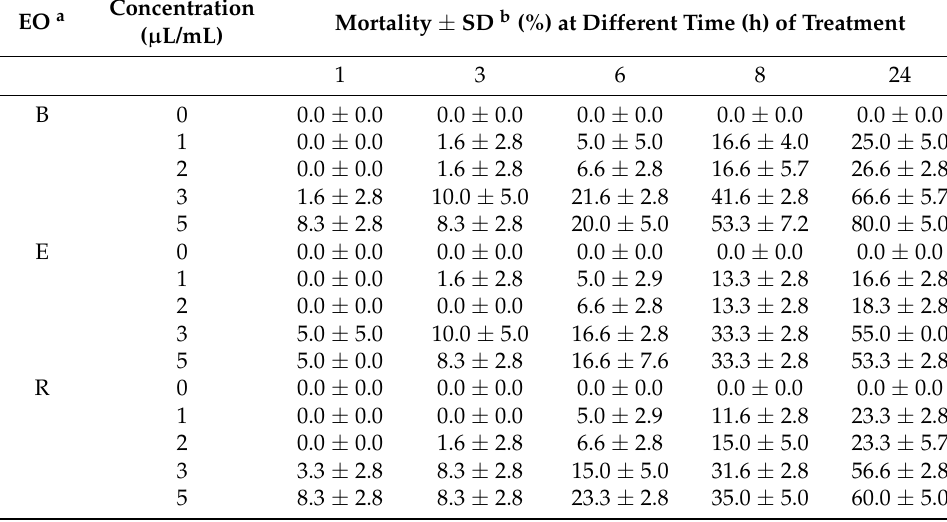
Table 2. Mortality of aphids Myzus persicae after contact treatment with four pure essential